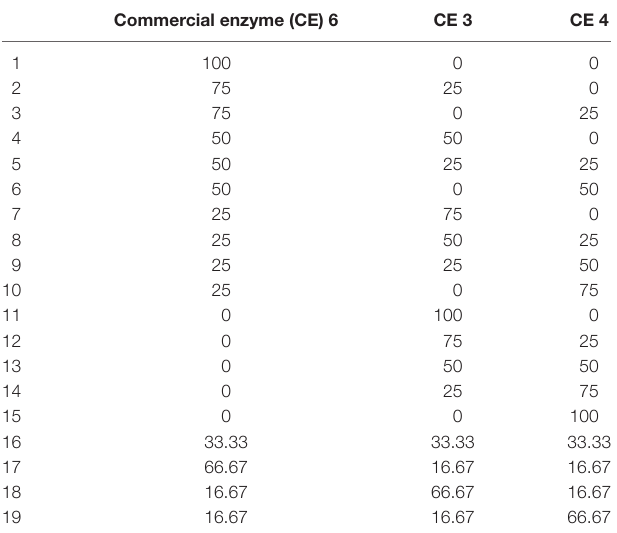
TaBle 2 | composition of enzyme mixtures (milligram basis) tested to study effect of particle size on yields. commercial enzyme (ce)